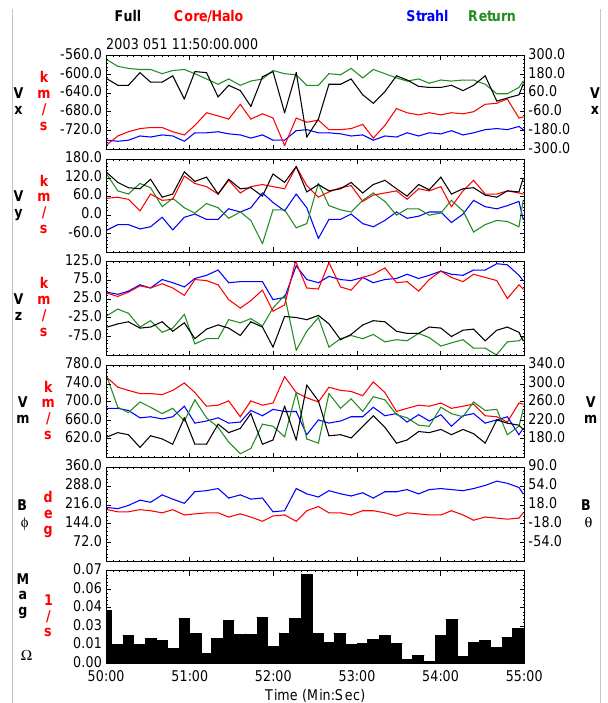
Fig. 12. Component velocities for the Full eVDF and the reduced component velocities for the Core/Halo, Strahl, and Return Popula- tion. All m are from C2. Also shown are the C2 magnetic field ϕ (red) and θ (blue) components and the magnitude of the vorticity. In the V x and V m panels the strahl and return velocities are plotted against the right-hand